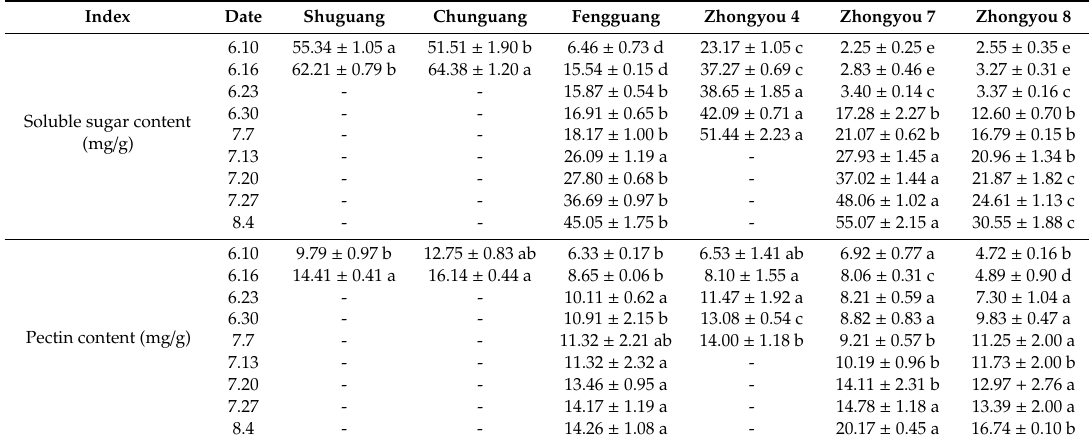
Table 7. The soluble sugar and pectin content of nectarine